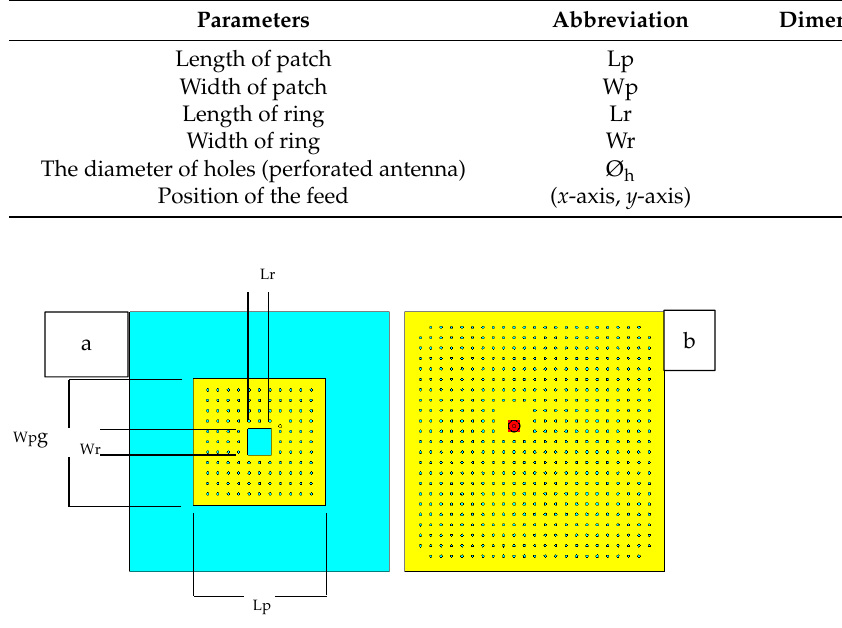
Figure 5. Front view ( a ) and back view ( b ) of the CST model of the perforated RRMPA. The direction of electromagnetic radiations radiated by the antenna is represented by its radiation pattern. These patterns represent the distribution of the radiated energy by the antenna into space, as a function of direction. The radiation patterns of the